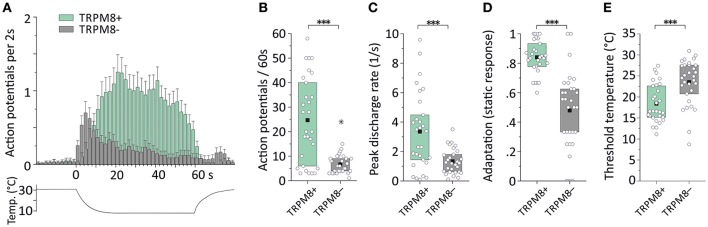
Cold response characteristics of TRPM8-positive and TRPM8-negative C57BL/6J mouse saphenous-nerve cold nociceptors. Distinction was based on TRPM8 pharmacology (see text) and includes CMC and CMCH types. (A) Averaged histogram summarizing the cold responses of all TRPM8-positive (green, n = 30) and TRPM8-negative (gray, n = 30) cold nociceptors in bins of 2s. Adjacent data points were subjected to 3pt averaging. (B–E) Quantification of parameters illustrates TRPM8-positive cold nociceptor responses as (B) larger in response magnitude counted as action potentials per 60s cold stimulus (p < 0.0001), (C) higher in peak firing frequency (p = 0.0001) (D) able to produce static, sustained responses quantified as fraction of the action potentials discharged during the constant cold stimulus (16–60 s) (p < 0.0001) and, (E) with lower threshold temperatures (p = 0.0002). All values are given in Table 3. Asterisks refer to Student's t-test. Boxes illustrate median and upper and lower quartiles. Outliers are marked with stars; one outlier in (C) was out of range (value 18.3); outliers were not included in calculation of mean and quartiles.